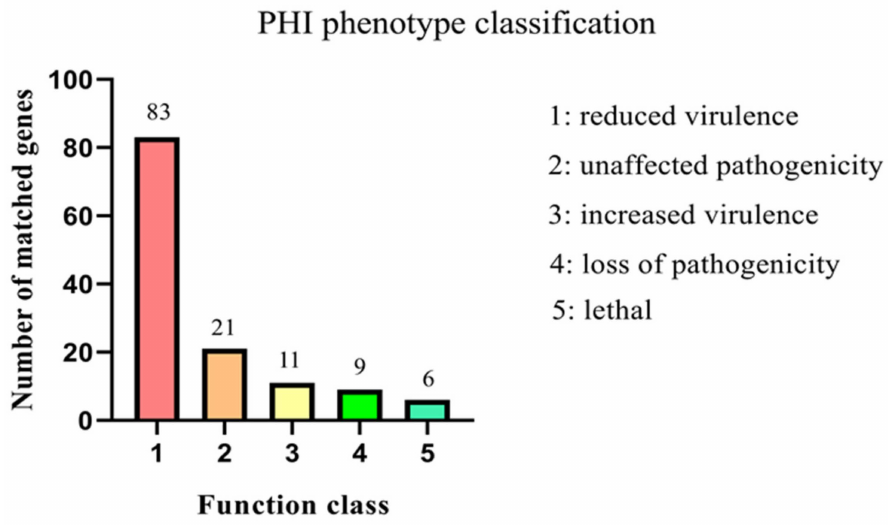
Figure 3. PHI database annotation results of the Mmc HN-A genome. Note: The abscissa indicates the type of phenotypic mutation. The ordinate indicates the number of